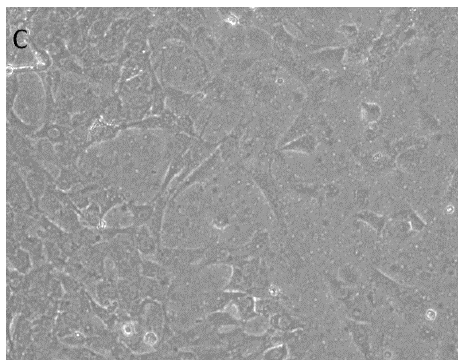
Figure 10. Phase-contrast microscopy images of osteoblasts grown for 24 h on ( A ) control, ( B ) Fe 3 O 4 @CS coatings, and ( C ) Fe 3 O 4 @CS/LyZ coatings (objective 10×).